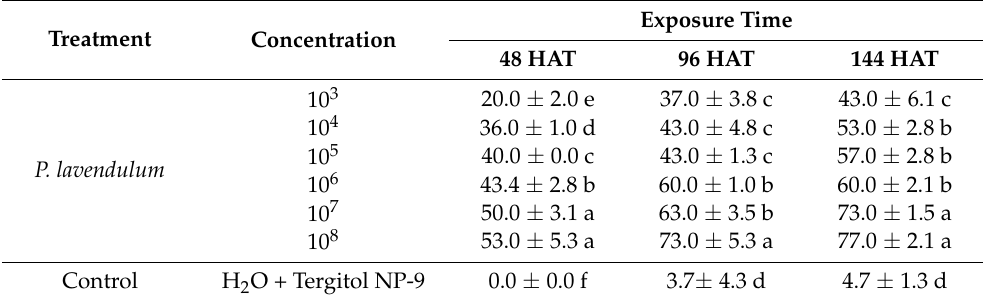
Table 2. Mean mortality ( ± SD) of T. pityocampa larvae. There is no significant difference between the mean of the same column followed by the same letter (Tukey’s test, a = 0.05), HAT: Hours After